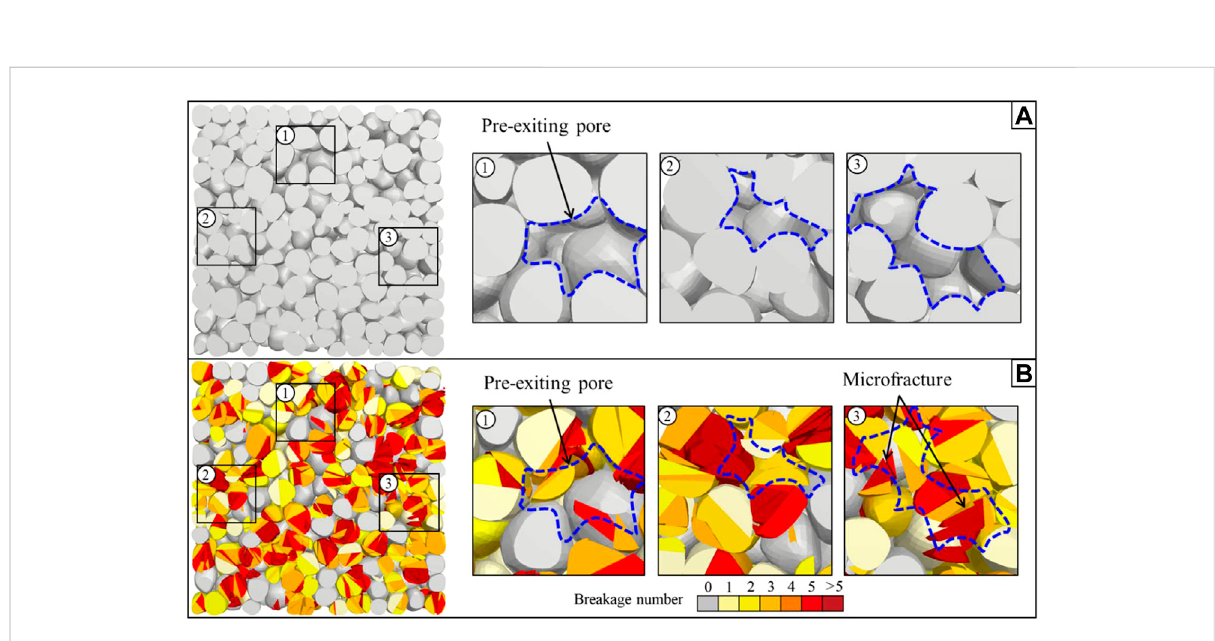
FIGURE 21 Section characteristics of the sample when the vertical stress is 50 MPa: (A) simulation without breakage and (B) simulation with breakage.